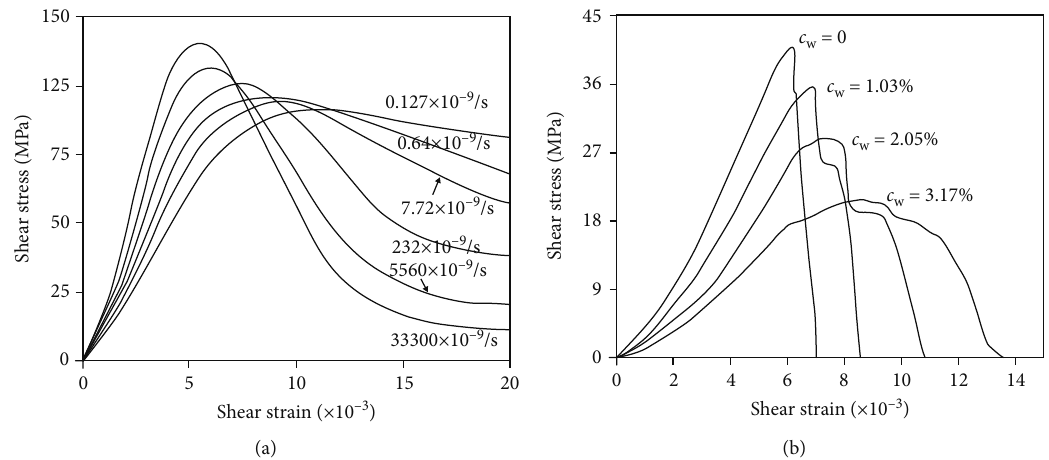
Figure 5: Shear stress − strain curves of rocks for various (a) strain rates [27] and (b) water contents ( c higher water contents result in less sharp curves, which correspond to lower m